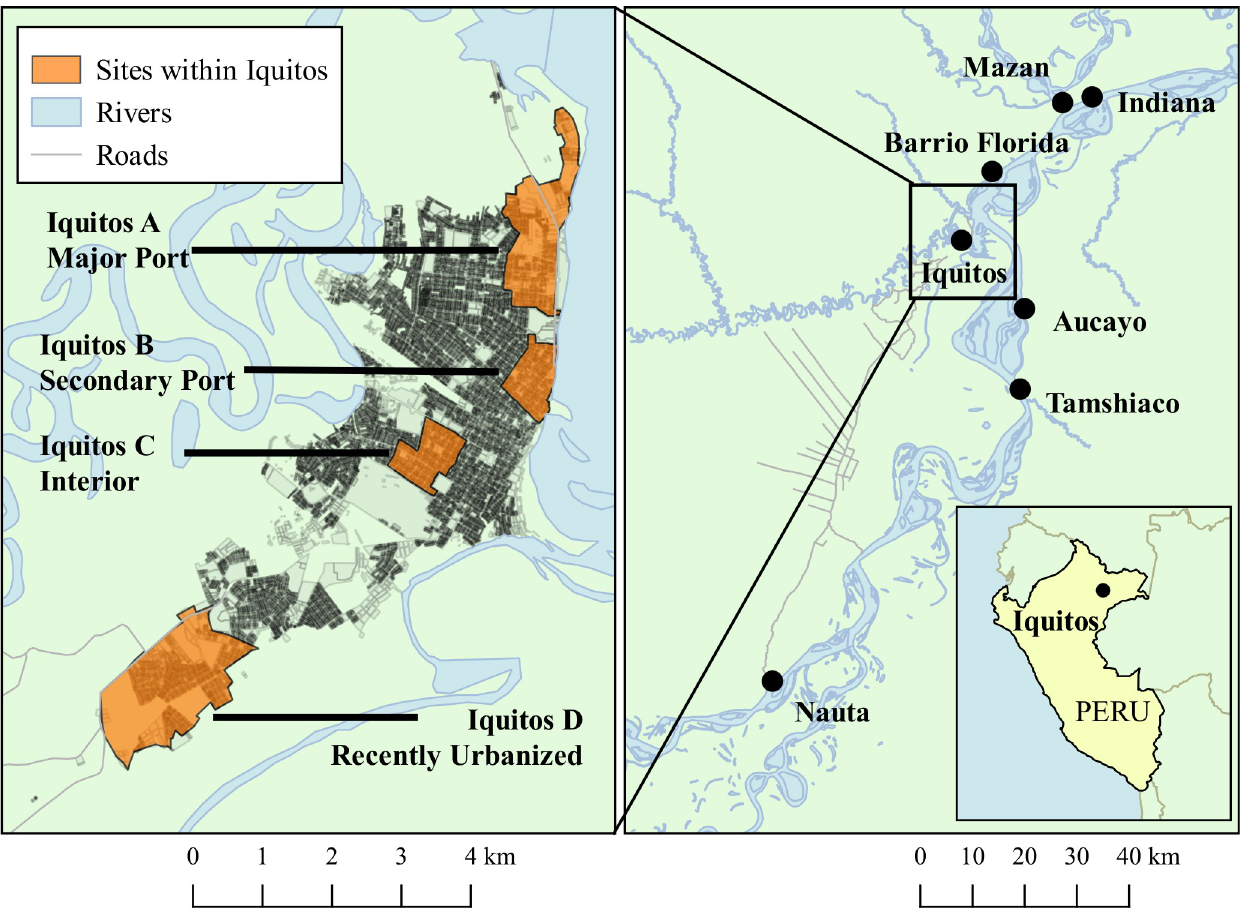
Fig 1. Map of Ae . aegypti collection sites in the Peruvian Amazon. We collected Ae . aegypti mosquitoes from seven population centers in the Peruvian Amazon: Iquitos, Nauta, Aucayo, Tamshiaco, Barrio Florida, Indiana, and Mazan. Collections from Indiana and Mazan were pooled into a single group to ensure > 20 individuals per site. In addition, we collected mosquitoes from four locations within Iquitos, two port sites and two interior non-port sites.